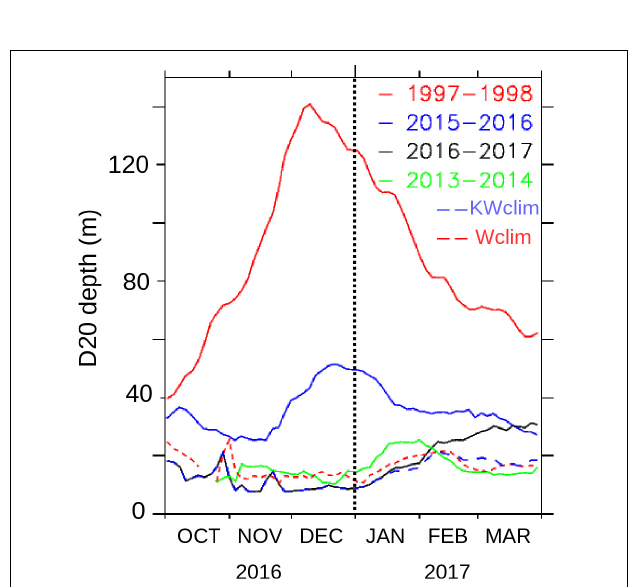
FIGURE 7 | Time evolution of the depth of the 20 ◦ C isotherm (D20, in meters) between October (year–1) and March (year+1) for different time periods (see labels). D20 was averaged in a coastal box between 4 ◦ S and 10 ◦ S and within 200 km from the